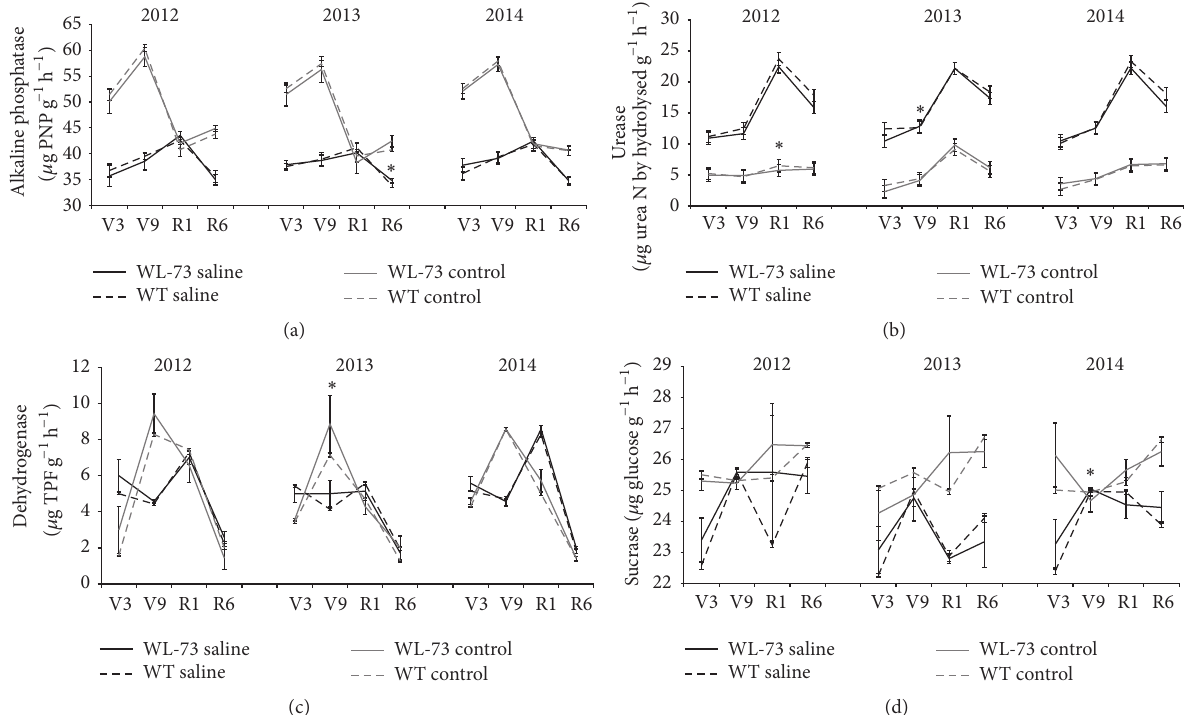
Figure 5: Activities of four enzymes in rhizosphere soil at different sampling times. (a) Alkaline phosphatase activity; (b) urease activity; (c) dehydrogenase activity; (d) sucrase activity. WT, wild-type maize LH1037; WL-73, LH1037 plant transformed with BcWRKY1 ; V3, the three lowest leaves have a visible collar; V9, nine leaves have collars present; R1, silking; R6, physiological maturity. ∗ indicates a significant difference at 𝑃 < 0.05 according to the LSD test ( 𝑛 = 3 ). The standard error is based on the average of three biological replicates. Note: during the three years of this study, there were no overall significant differences ( 𝑃 > 0.05 ) in the alkaline phosphatase, urease, dehydrogenase, or sucrase activity in rhizosphere soil of WL-73 and WT plants in two soil environments (saline or nonsaline) or at four growth stages (V3, V9, R1, and R6). In addition, the activities of these four soil enzymes were not significantly different between WL-73 and WT plants in some soil environments, years, and growth